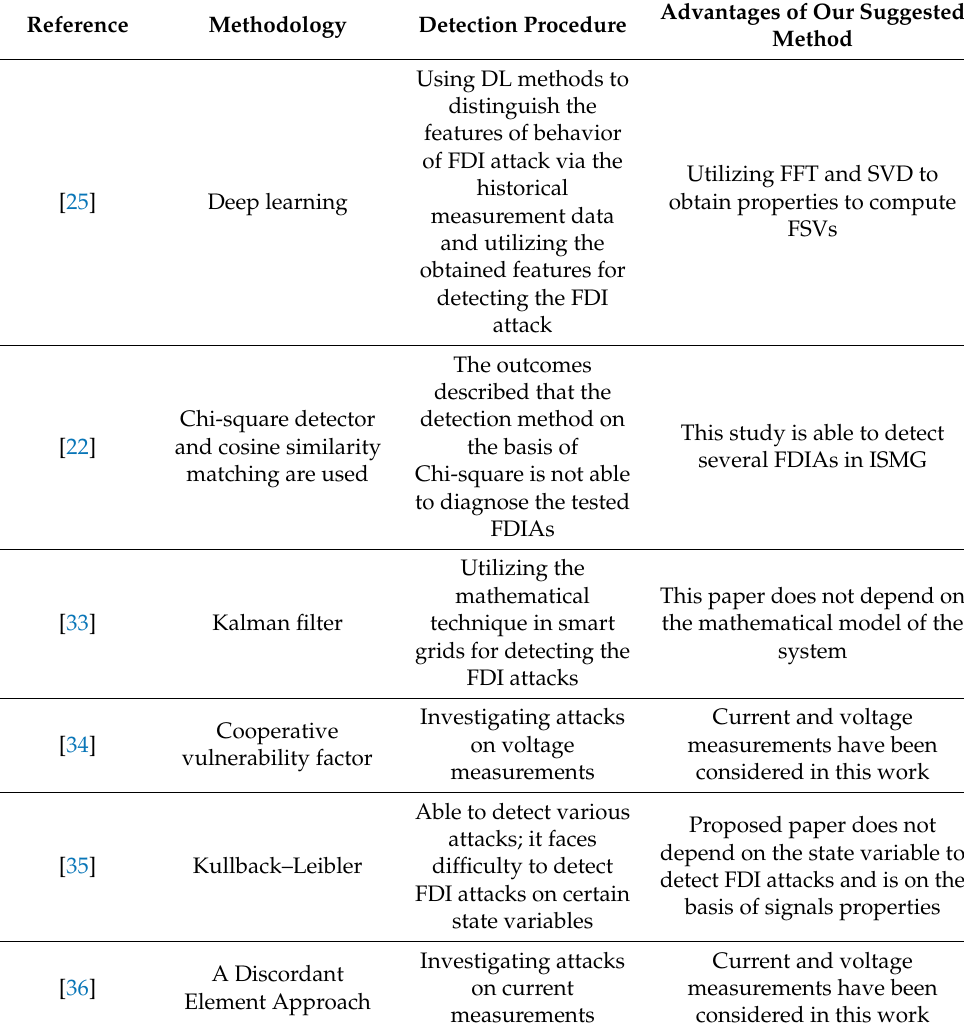
Table 1. Published literature of FDI attack detection in smart electrical